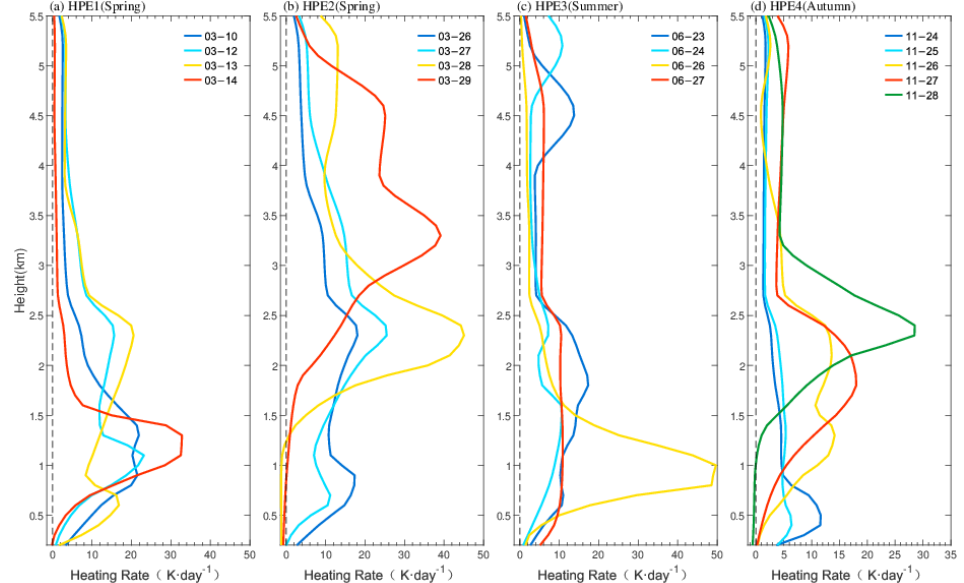
Figure 8. Vertical profiles of HR due to aerosol, calculated from ground-based observations during heavy pollution episodes (HPE1, 2, 3, and 4) in Beijing in 2018.